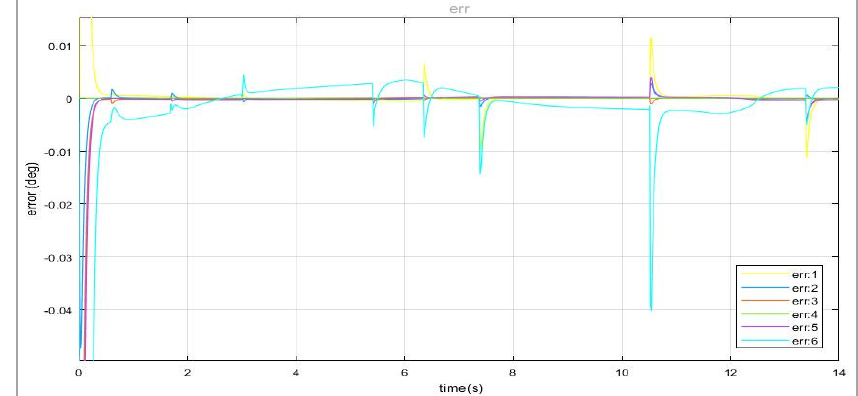
Fig. 13. Tracking Error/ PD-CTC.